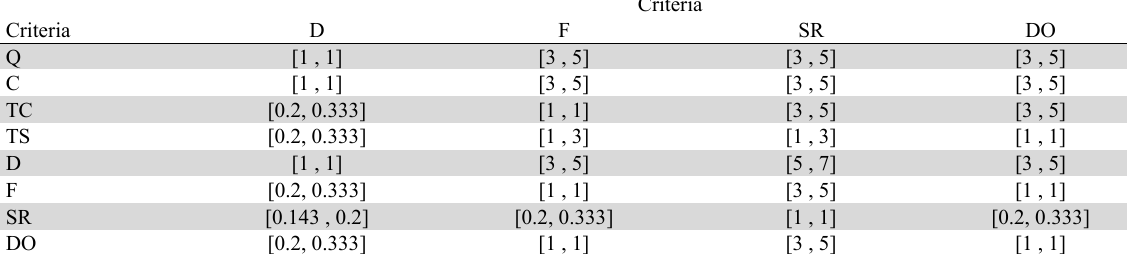
The Results of G-AHP model